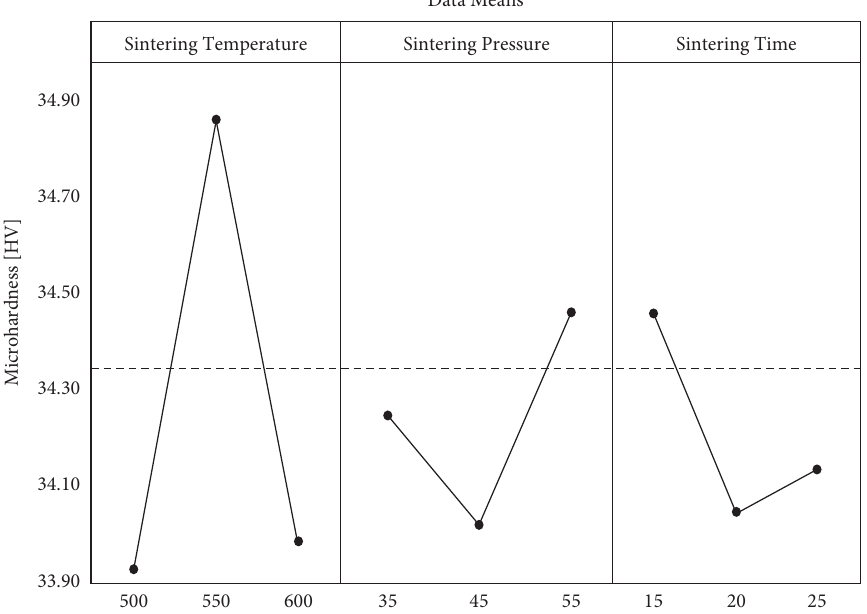
Figure 5: Efect of processing parameters on S/N ratio of microhardness. Table 2: Results of experiments sorted by sintering factors for mean microhardness HV and signal-to-noise. Experimental run